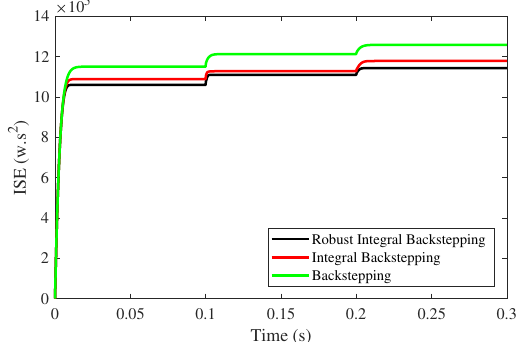
Figure 13. ISE for varying temperature and